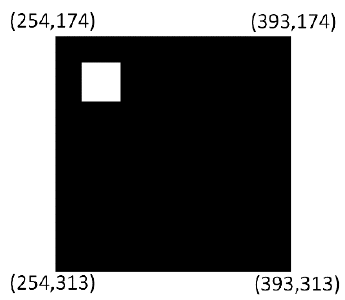
Figure 13. Illustration of input frame with one marker located in the center.